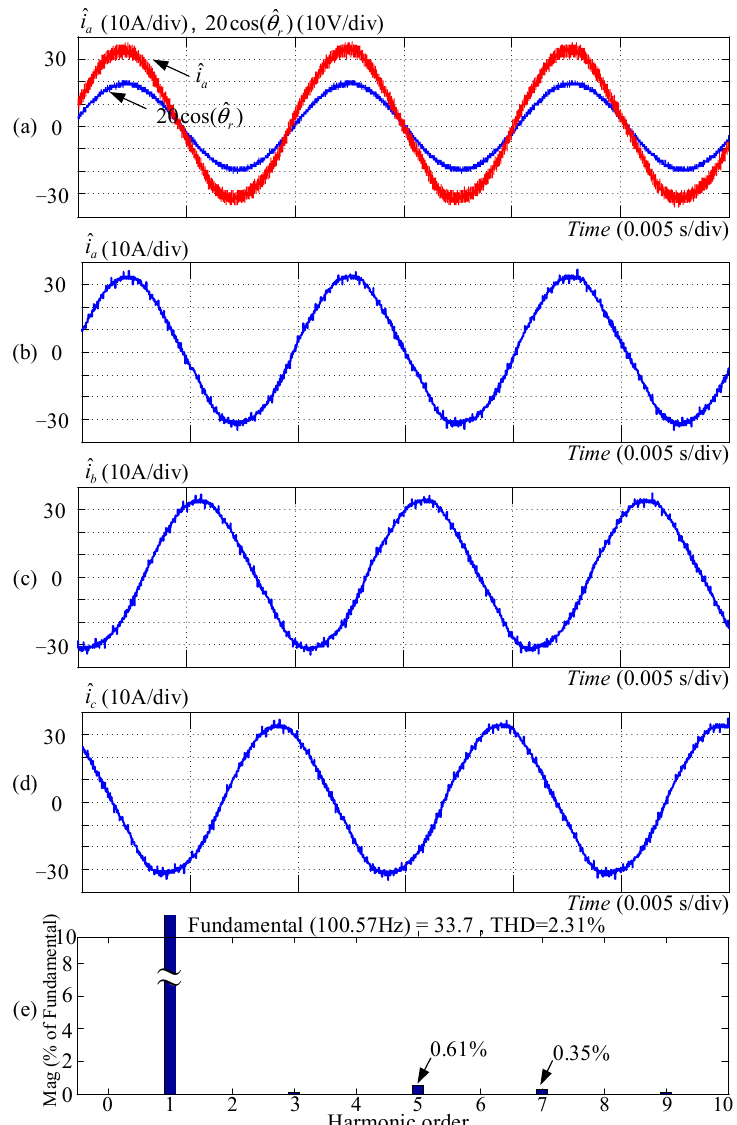
Figure 13. Measured phase currents of a three-phase permanent-magnet synchronous motor driven at 1500 rpm with a compensation strategy for harmonic components in induced EMF along the q-axis and d-axis: ( a – d ) measured phase currents ˆ i a , ˆ i b and ˆ i c ; ( e ) spectrum of phase current ˆ i a . The current response transformed onto the q-axis and d-axis is as shown in Figure